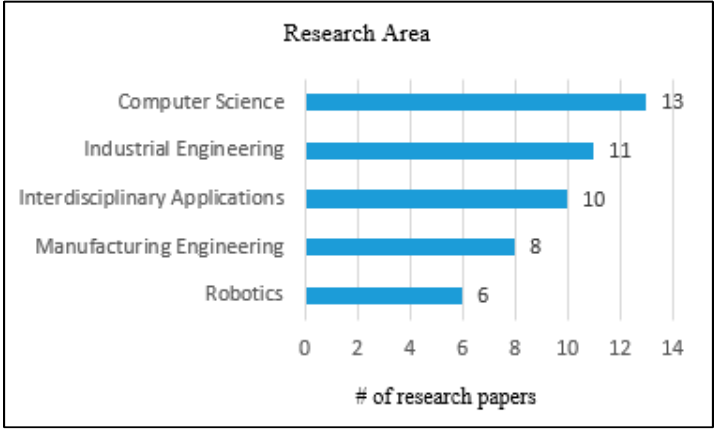
Figure 4. The fi ve most frequent research areas.